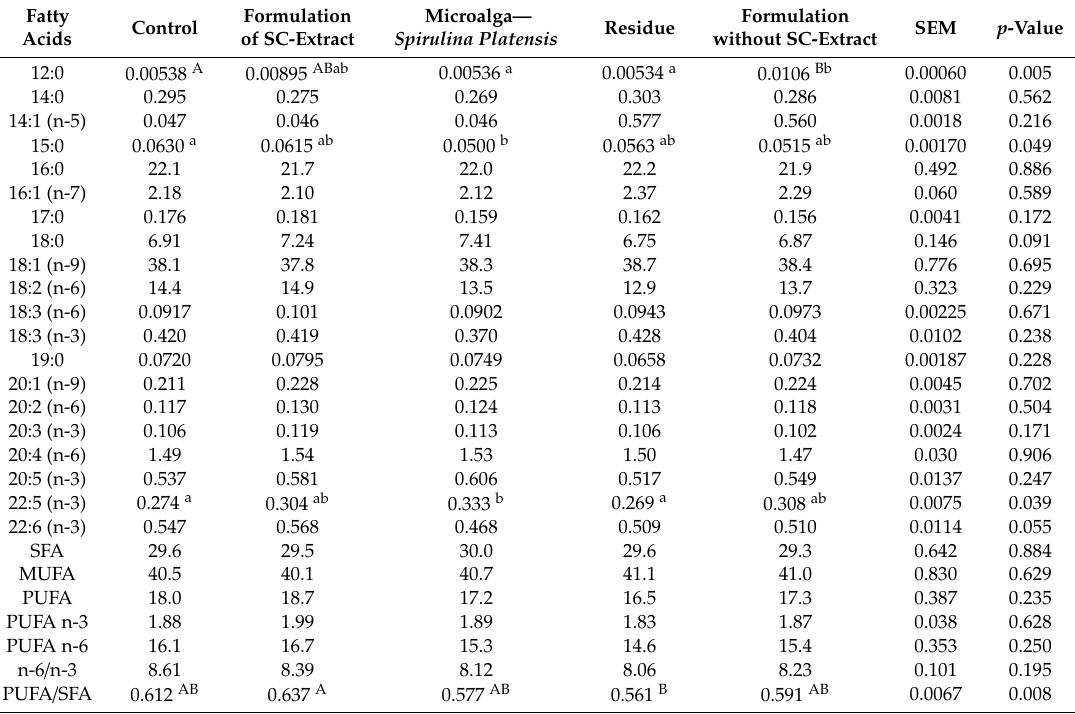
Table 8. The content of FAs in the eggs (% weight of FAs in the sample) after 120 days of the experiment. Formulation Formulation Microalga— Fatty Residue Control Spirulina Platensis without of SC-Extract Acids